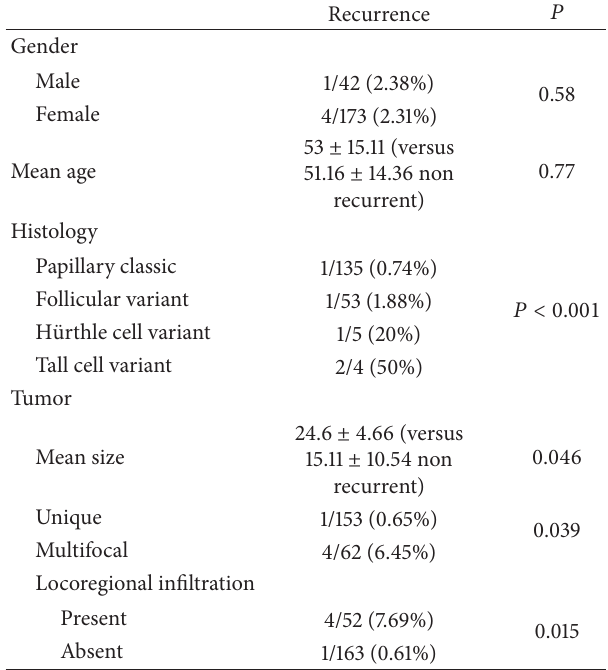
Table 3: Risk factors of recurrence: gender and